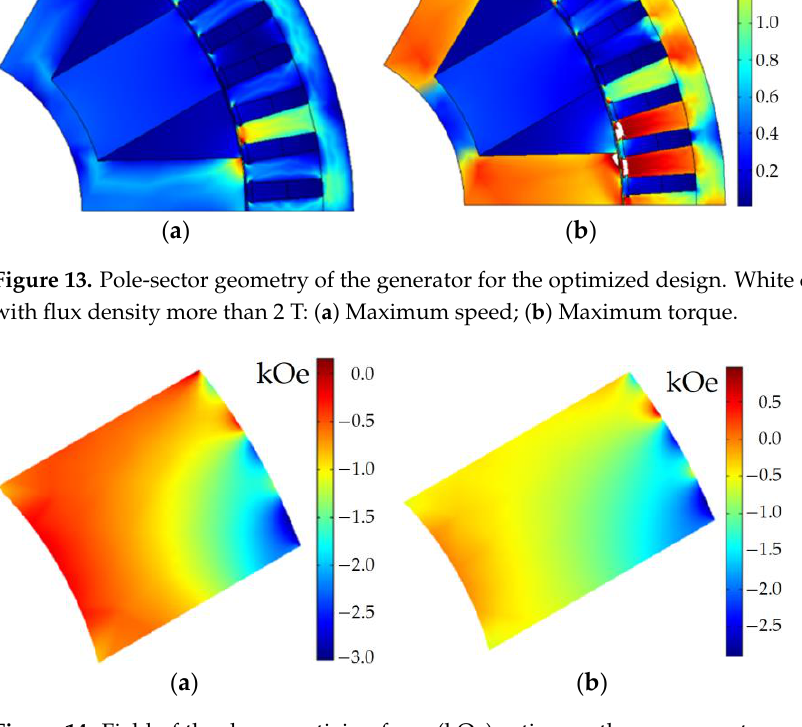
Table 4. Characteristics of generators without magnets and with ferrite magnets. Characteristics